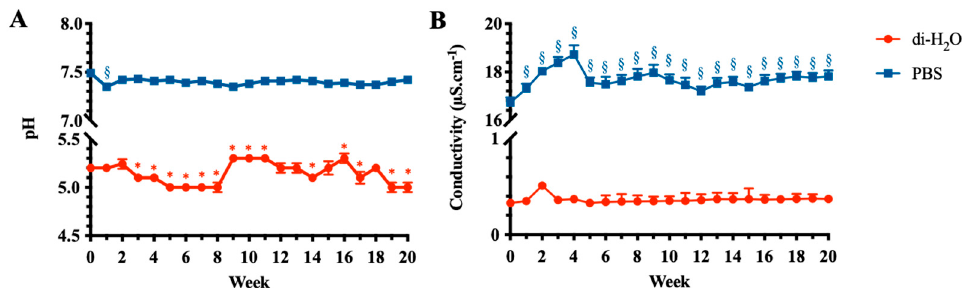
Figure 4. Degradation characteristics of the electrospun PLGA scaffolds under PBS and di-H 2 O conditions. ( A ) pH and ( B ) conductivity values of PBS and di-H 2 O along the degradation studies. * and § statistically significant vs. week 0 ( p < 0.05). Statistical symbols in blue and red refer to di-H 2 O and PBS, respectively.